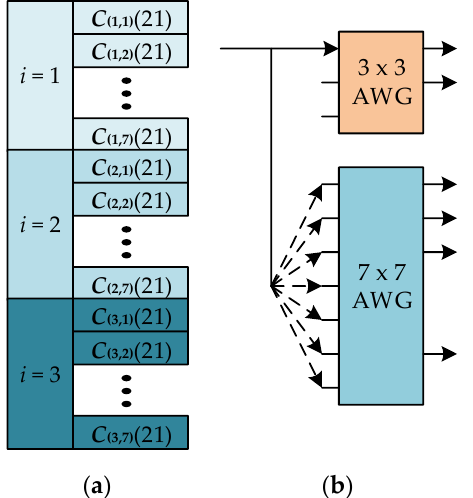
Figure 7. The optical buffering scenario for low-QoS packets. ( a ) Code partition method; ( b ) encoder setup.